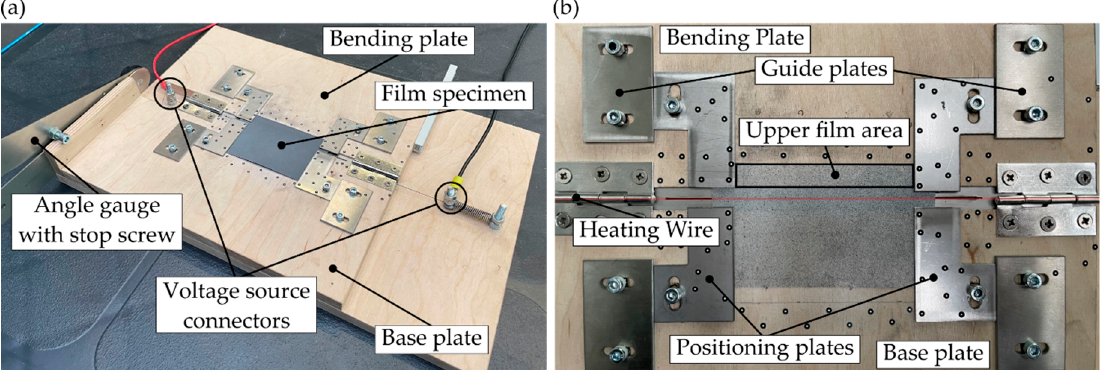
Figure 3. ( a ) Bending device with clamped film specimen and power supply and ( b ) top view of the components of the plate that enabled adjustments within the bending process.